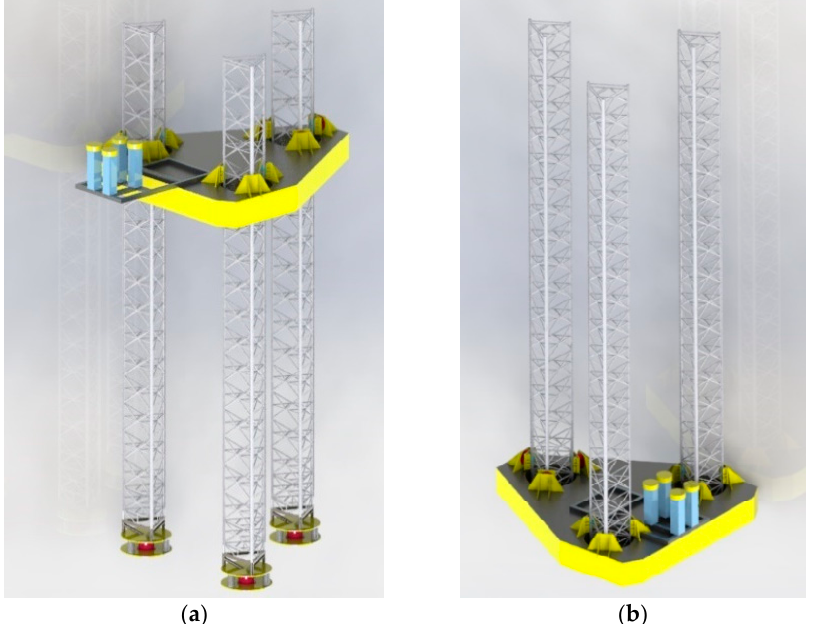
Figure 1. Conceptual design of the in-house developed generic self-elevating unit: ( a ) elevated condition, ( b ) transit condition.